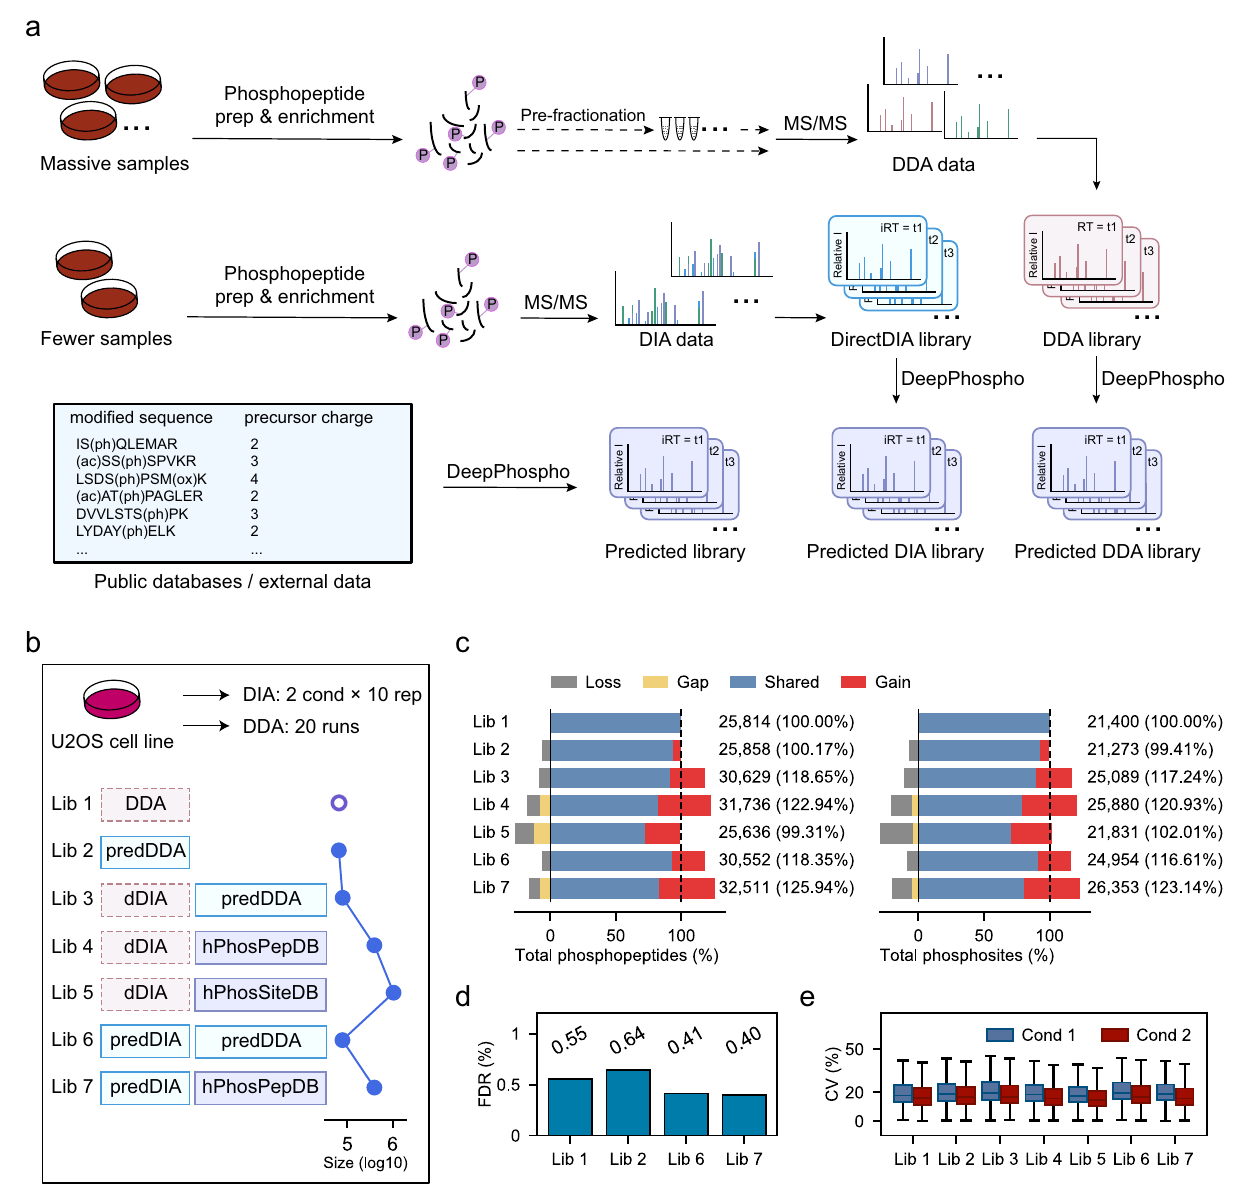
Fig. 3 Generation of DeepPhospho predicted libraries for DIA phosphoproteomics data mining. a An experimental DDA library or direct DIA library can be converted to a predicted DDA library or a predicted DIA library by DeepPhospho. A predicted library can be also generated from public phosphoproteome or phosphosite databases, or external phosphoproteomics data. b Design of seven spectral libraries for the U2OS DIA data analysis. DDA/dDIA, experimental DDA or direct DIA library; predDDA/predDIA, predicted libraries converted from the DDA and DIA library; hPhosPepDB/ hPhosSiteDB, predicted libraries built from public human phosphoproteome and phosphosite databases. Lib 3 to Lib 7 are comprised of two separate libraries. c Number of phosphopeptides and phosphosites identi fi ed using each library. Percentage of the total phosphopeptide or phosphosite number is shown for each predicted library relative to the project-speci fi c DDA library (Lib 1). The proportions of shared identi fi cations (IDs), gained IDs, lost IDs,